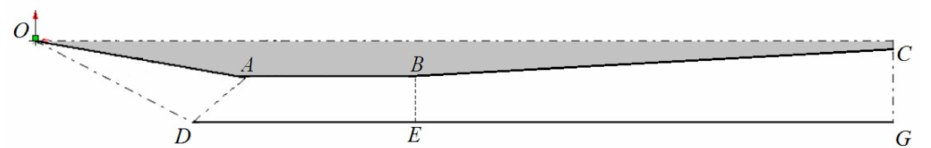
Figure 1. Schematic diagram of the fixed-geometry inlet scheme. A : End of compression surface; B : Start point of expansion section; C : End point of expansion section; D : Inlet cowl lip; E : Throat point of lower wall; G : End point of lower wall; O : Leading edge